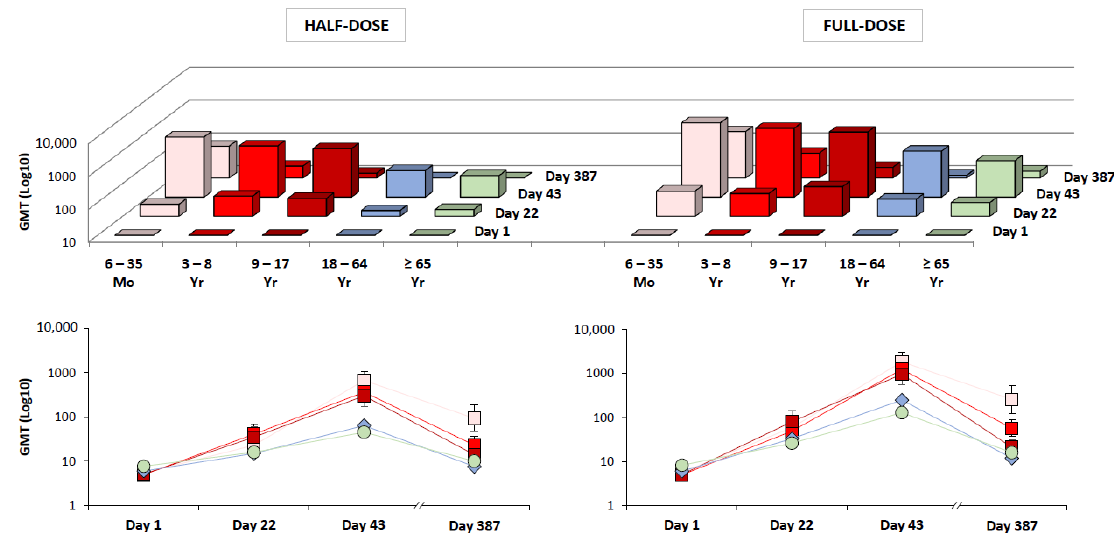
Figure 1. Geometric mean antibody titers (GMTs; hemagglutination inhibition assay) at baseline (Day 1), three weeks after first dose (Day 22), and three weeks (Day 43) and twelve months (Day 387) after second dose administration. Data for subjects 6 months–17 years, 18–64 years, and ≥65 years of age derived from Studies A, B and D, respectively (Full Analysis Set data). Three-dimensional column graphs and line graphs show identical GMT data in response to half-dose and full-dose formulations. Line graphs show 95% CIs for Study A and Study B data (subjects 6 months–64 years of age), and 97.5% CIs for Study D data (subjects ≥ 65 years of age).